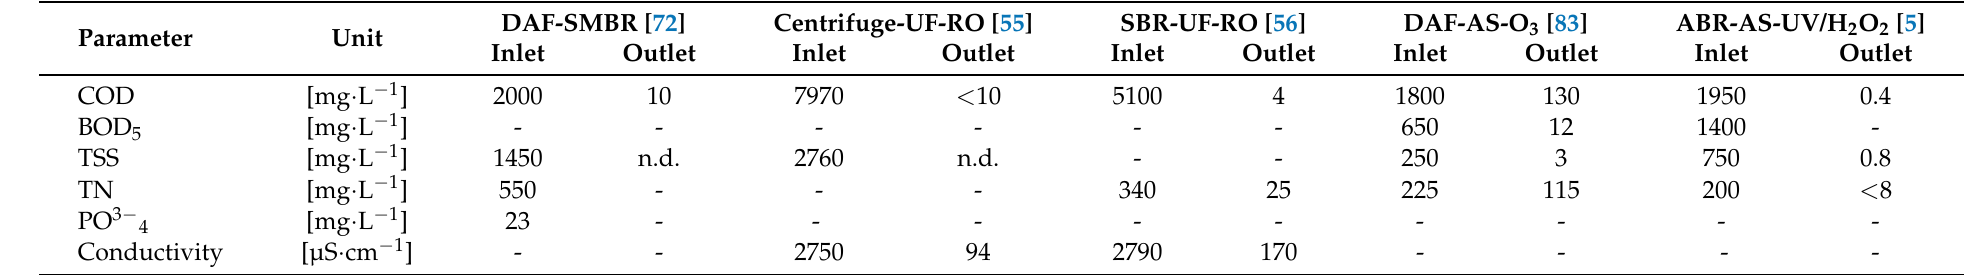
Table 6. Purification potential of combined